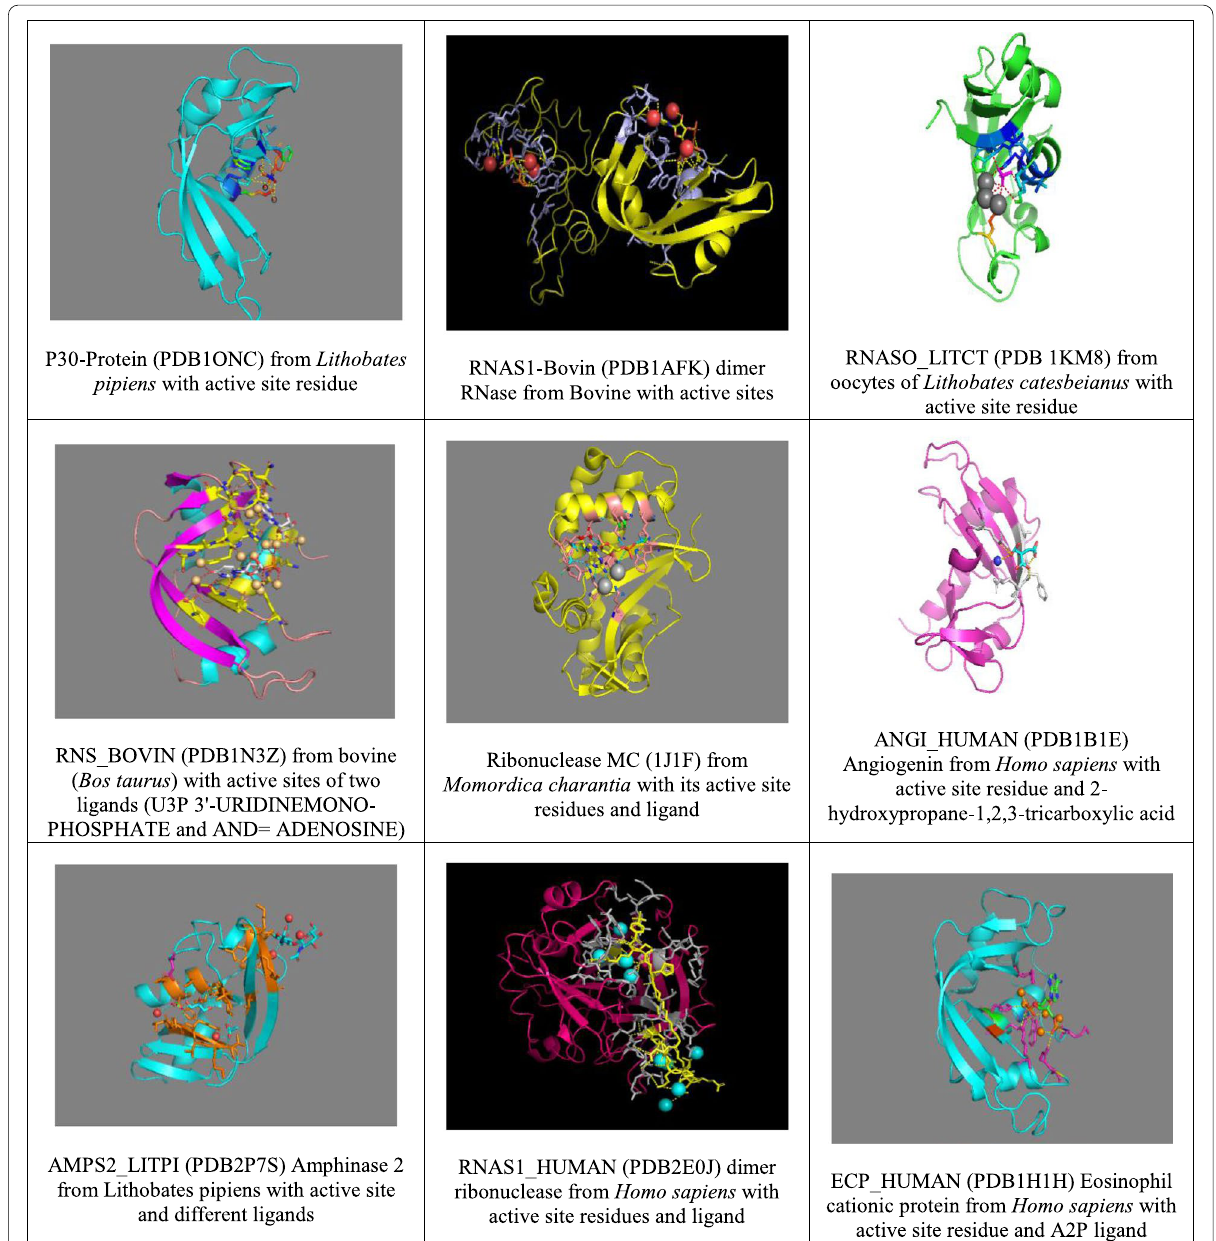
Fig. 3 3D structures of active site residues of certain eukaryotic ribonucleases in relation to preexisted ligands. Sphere in each active site of ribonuclease shows a polar interaction of ligand with water molecules which are considered as active water